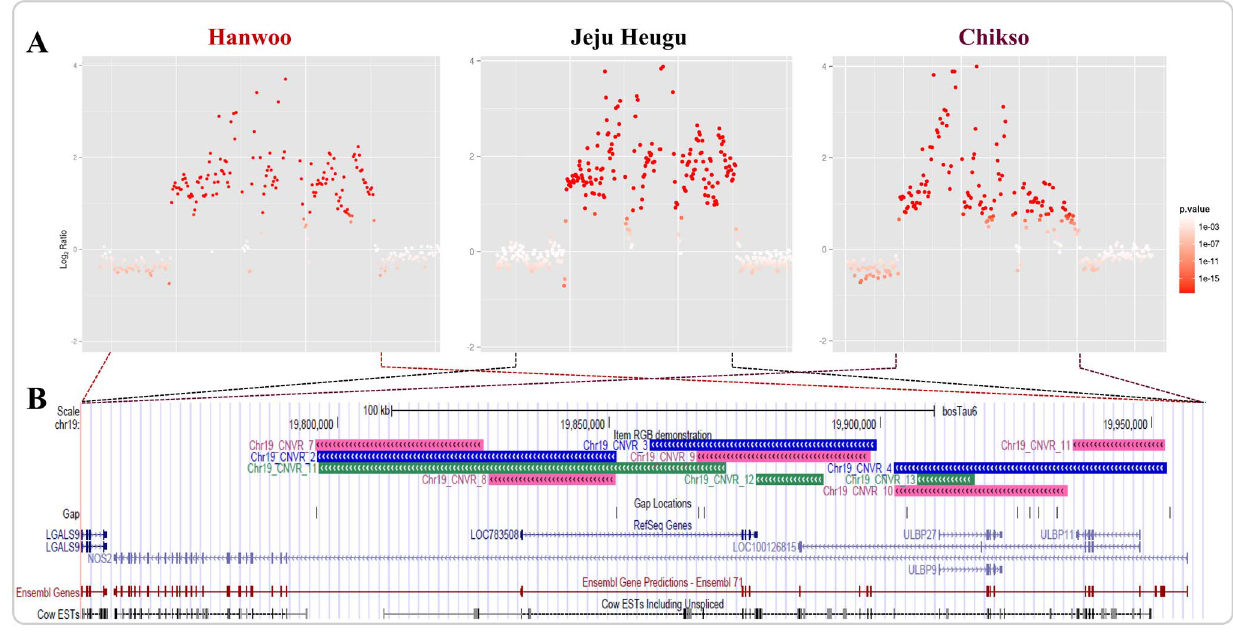
Figure 5. Copy number variation regions (CNVRs) overlapping the NOS2 gene region. (A) Log 2 ratio plot of the CNVRs overlapping the NOS2 gene region for Hanwoo, Jeju Heugu, and Chikso versus Holstein, respectively. Each point presents the log 2 ratio of the number of reads mapped in Korean Holstein versus the Korean native cattle breed. The color gradient indicates the log 10 p -value obtained from CNV-seq. (B) NOS2 gene regions in the UCSC Genome Browser. The colors pink, blue, and green indicate genic CNVR gains in Hanwoo, Jeju Heugu, and Chikso, respectively.